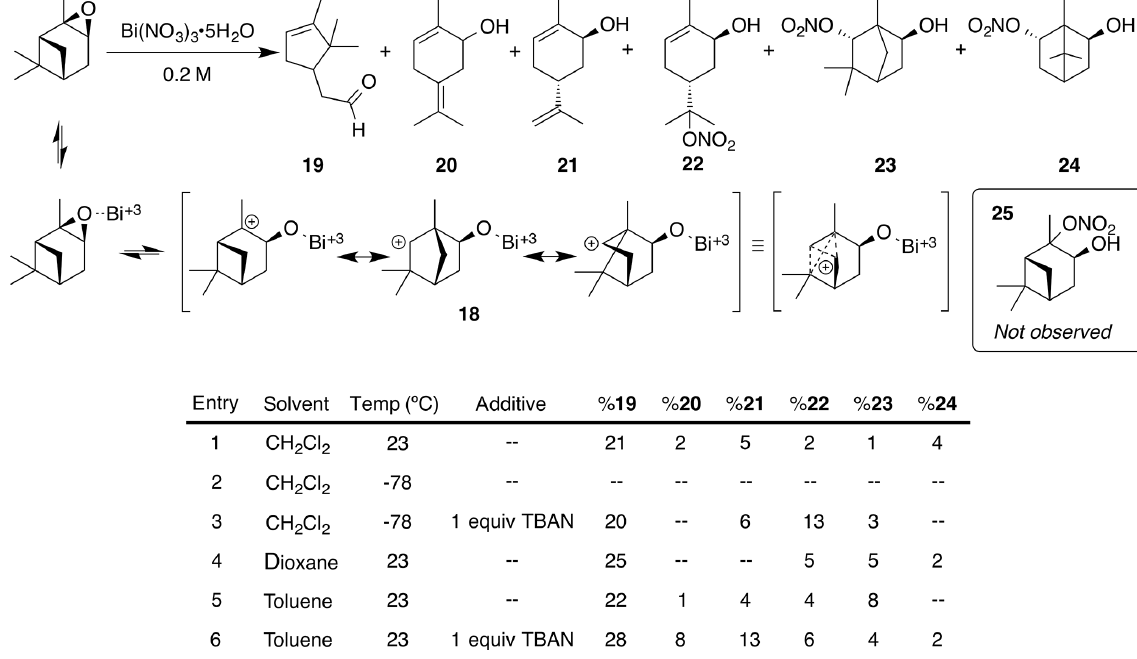
Figure 7. Nitration of α -pinene oxide.